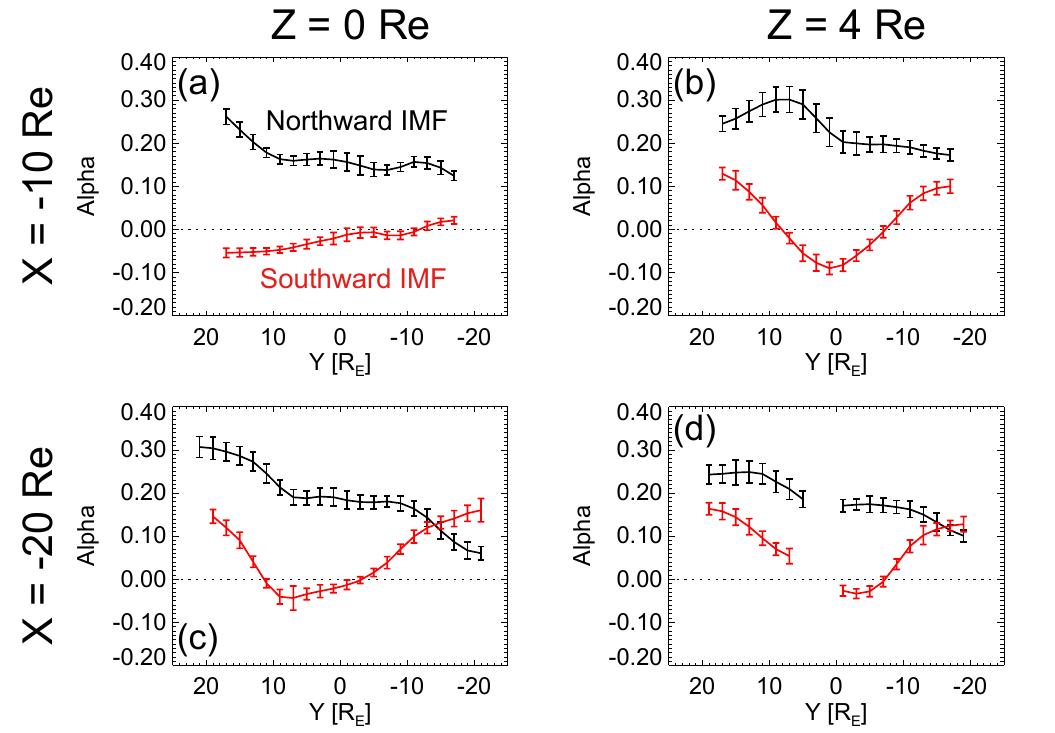
Fig. 7. Y profiles of IMF B z dependence parameter α for the northward and southward IMF conditions. Format is the same as Fig. 3. Error bar is Error bars 1- σ of